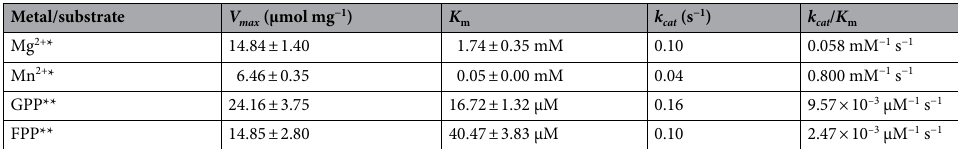
Table 1. Kinetic properties of Pam Tps1. *Values when Mg 2+ and Mn 2+ were used in the presence of 27 µM GPP. **Values for GPP and FPP were measured in the presence of 20 mM Mg 2+ . V max = Maximal velocity; K m = Michaelis–Menten constant; k cat = Turnover number; k cat / K m = Catalytic efficiency. Values were reported as the mean of relative activity ± SD of triplicate